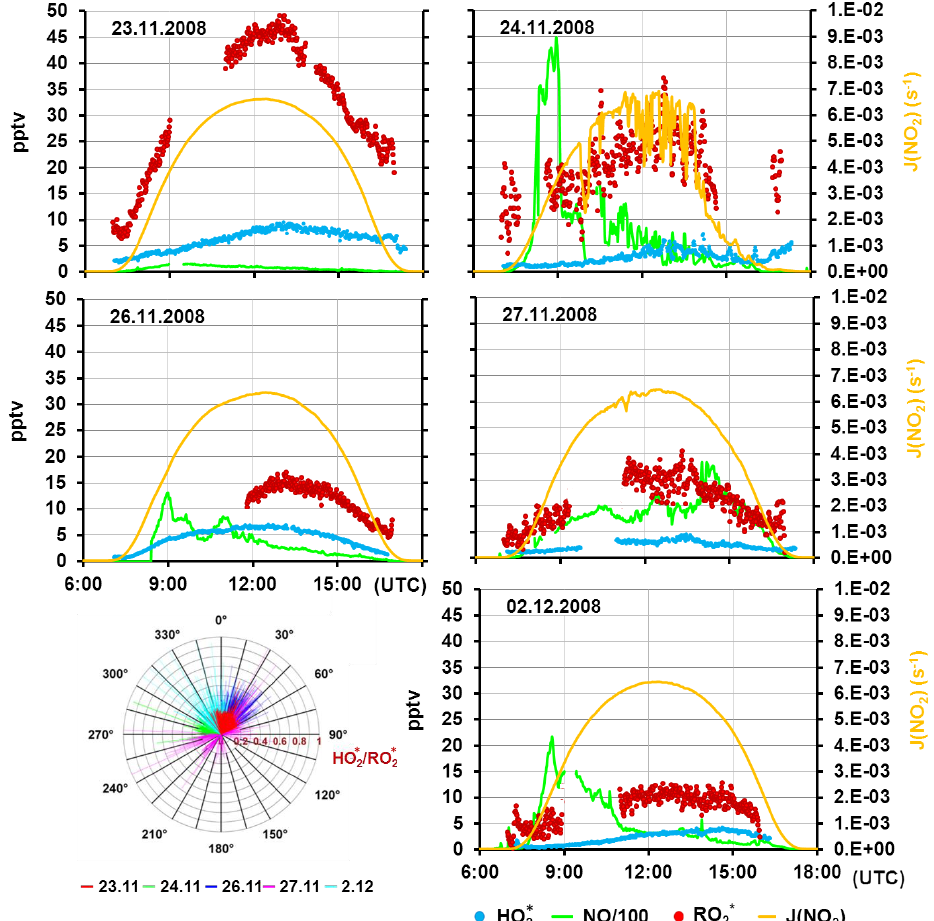
Fig. 7. Daylight RO ∗ and HO 2 measured by DUALER and HORUS, respectively, under clear sky conditions during DOMINO. Periods 2 without DUALER data corresponds with calibration of one of the NO 2 detectors, in which the DUALER method of analysis cannot be applied (see text). The photolysis frequency J (NO 2 ) and NO data are also included as additional information. RO ∗ averages are depicted without error bars to simplify the picture. The distribution of corresponding HO 2 / RO ∗ wind direction is additionally plotted (bottom